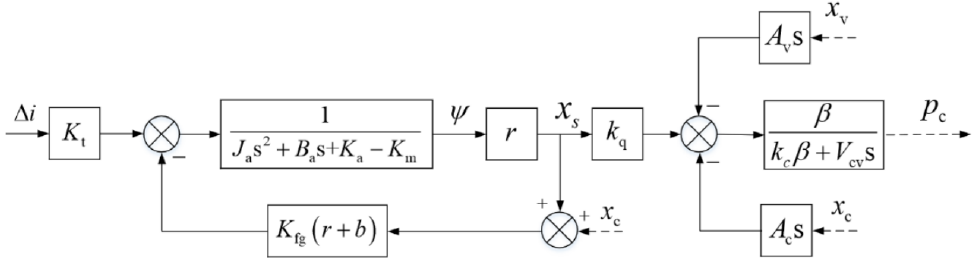
Figure 19. Control block diagram from control current to buildup pressure.